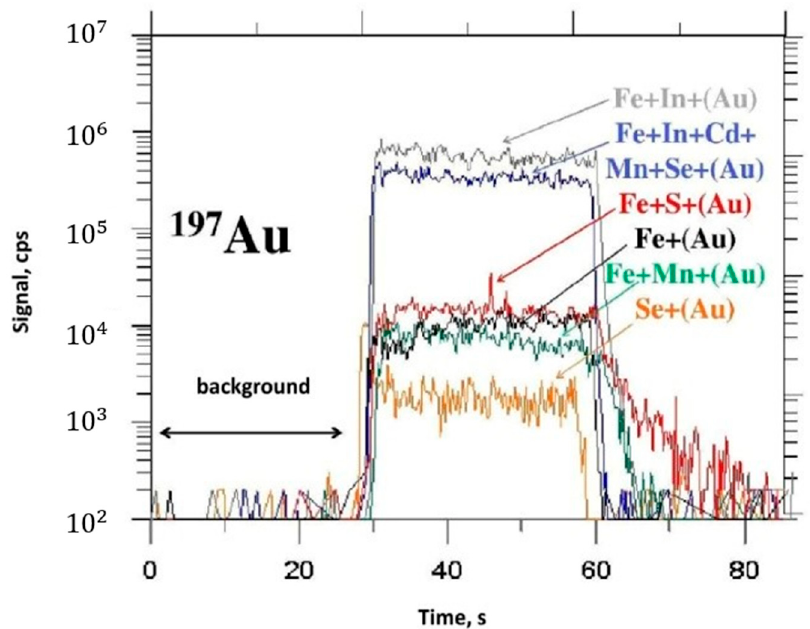
Figure 35. LA-ICPMS profile through sphalerite containing Au and different additional impurities. Salt flux synthesis at 850/750 °C, see Table 27 for details.